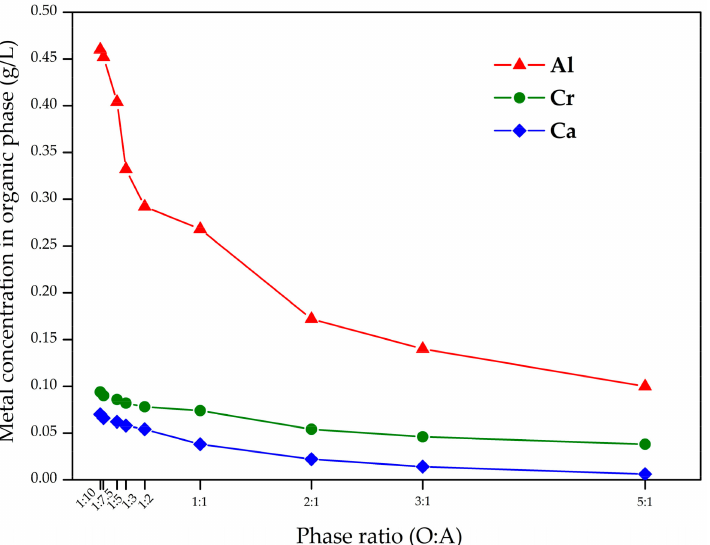
Figure 9. Al, Ca, and Cr(III) co-extraction with iron(III) at different O:A ratios at C(Al) = 2.7 g/L,